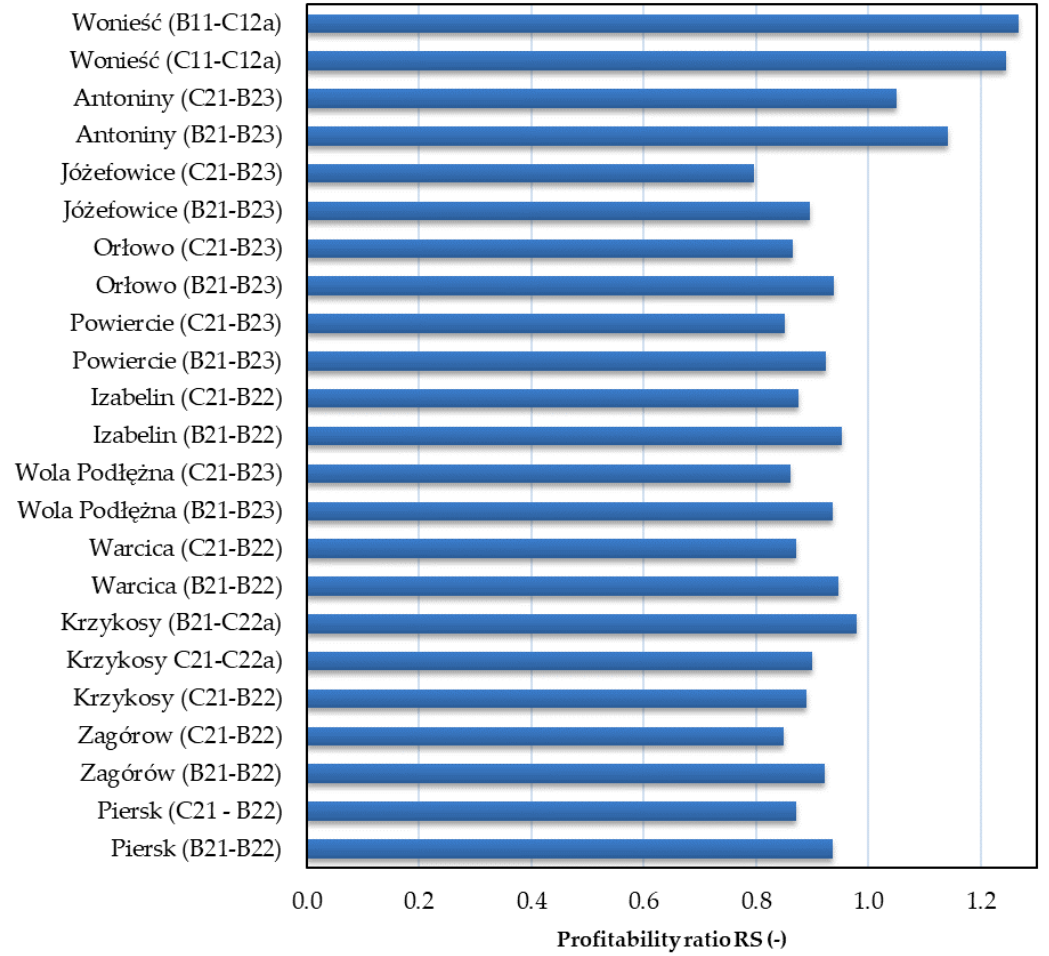
Figure 5. Profitability ratios (PR) of exemplary drainage pumping stations.